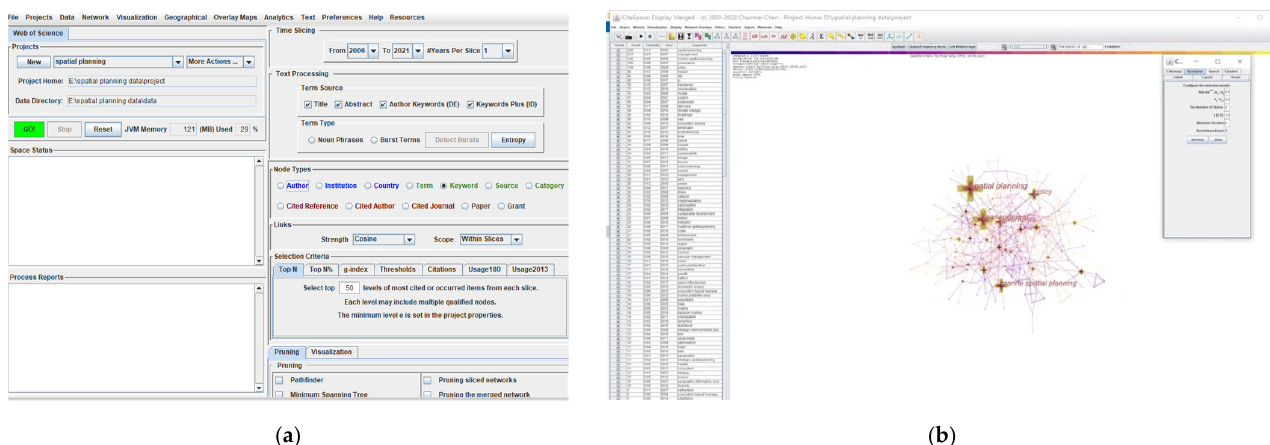
Figure 2. The original operation interfaces ( a ) and output interfaces ( b ).